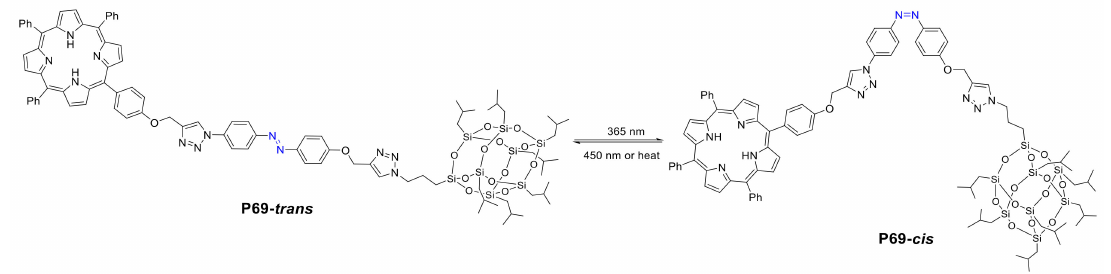
Figure 7. trans and cis configurations of P69 switching induced by light or